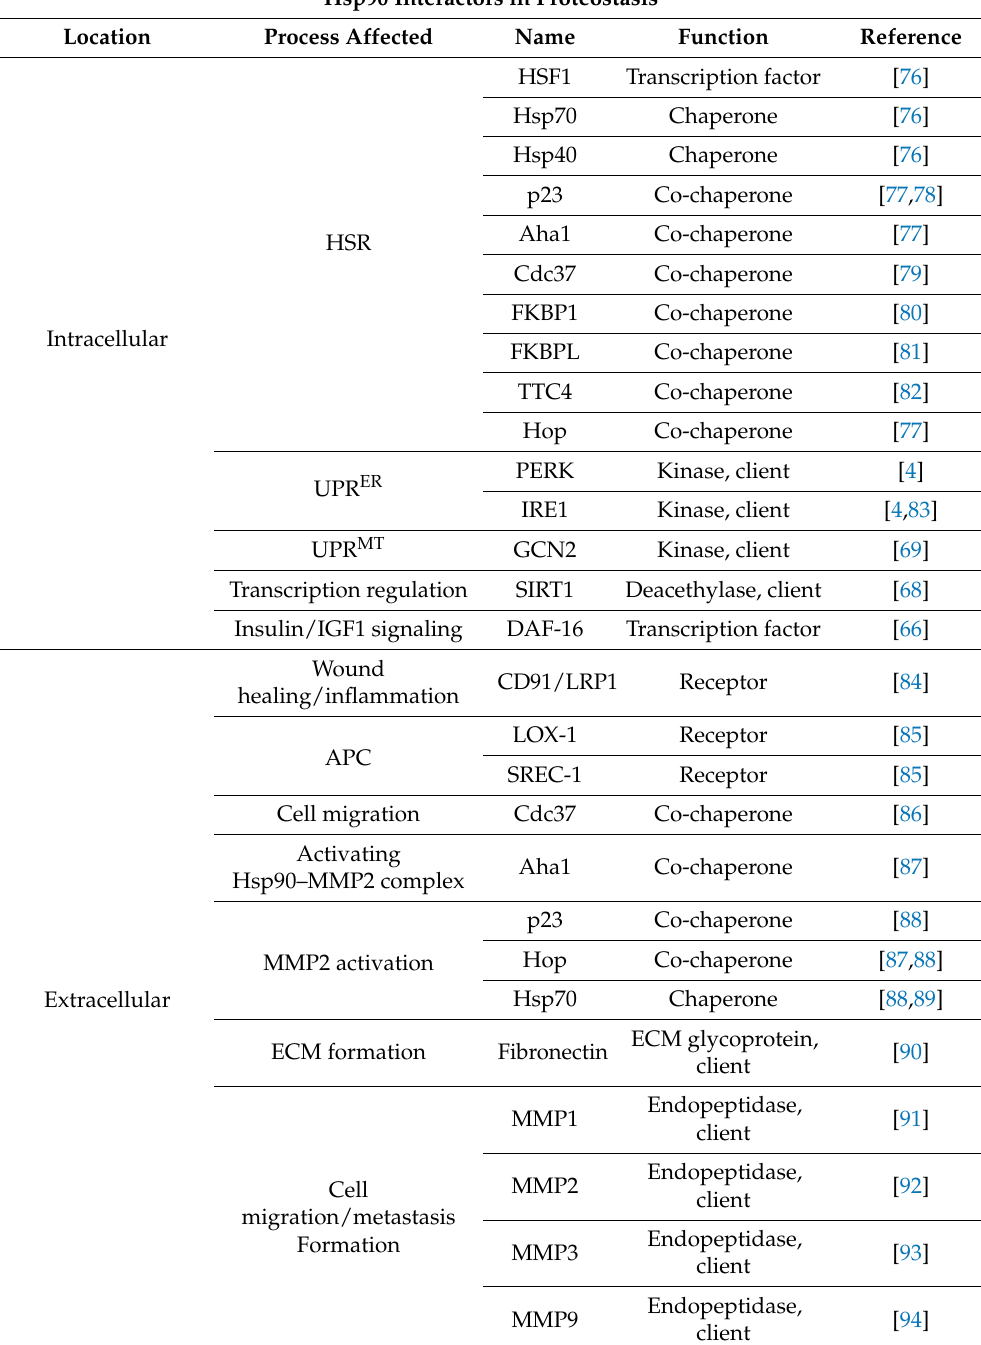
Table 1. Hsp90 interactors involved in